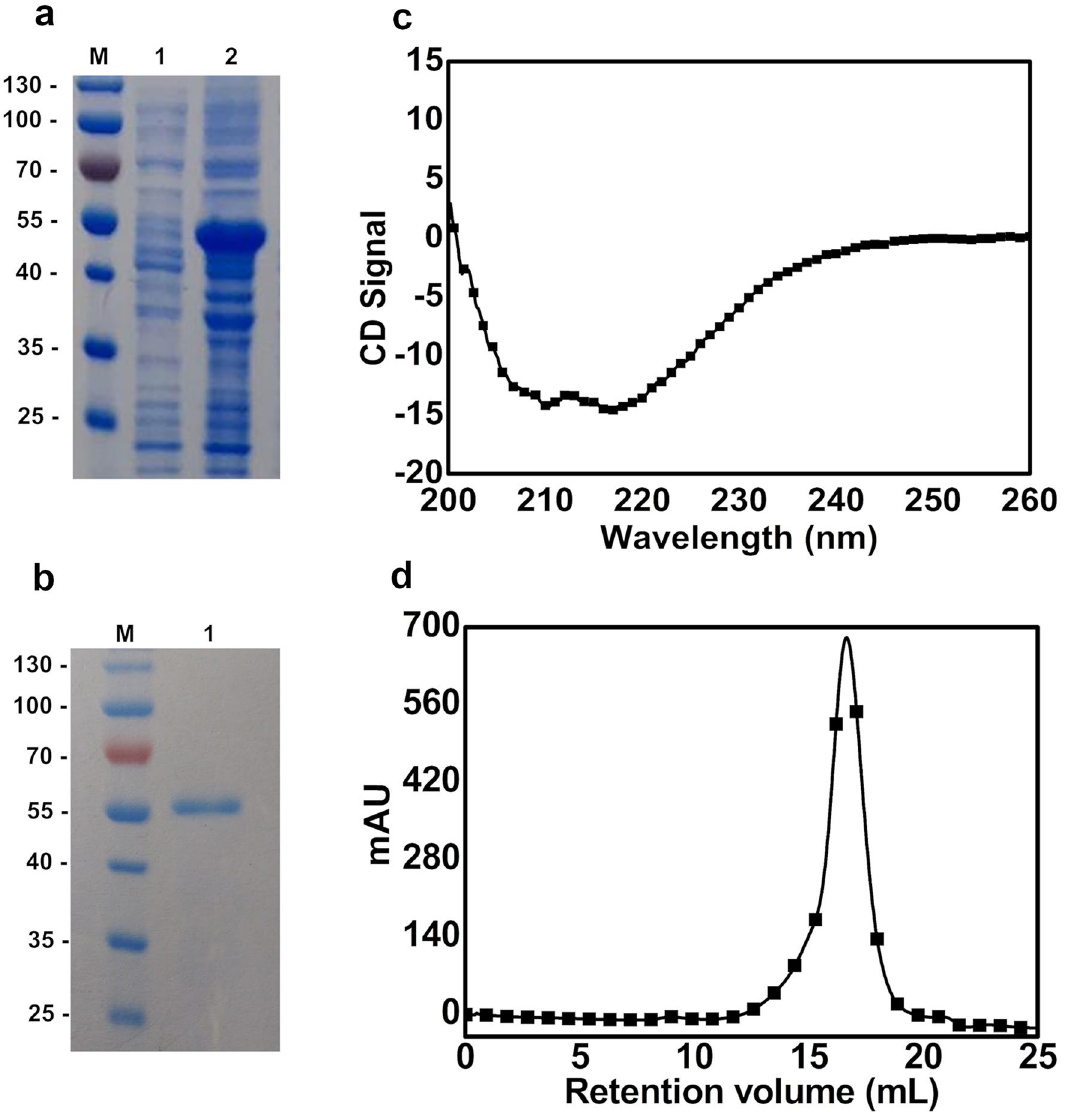
Figure 3. SDS-PAGE in 12% gels showing purification results and graphs of secondary and tertiary folding analyses. ( a ) Gel containing the soluble (1) and insoluble (2) fractions; M indicates the marker. ( b ) Gel containing purified ThABF, with as size of approximately 53.44 kDa (1), and a marker (M). Both gels ( a ) and ( b ) were stained for 30 min in a dye solution with Coomassie blue. The whole gels from the ThABF purification and from the soluble and insoluble fractions are shown in Supplementary Figs. S1 and S2. ( c ) Analysis of secondary folding components of the recombinant enzyme by circular dichroism. ( d ) Analytical size exclusion chromatography of